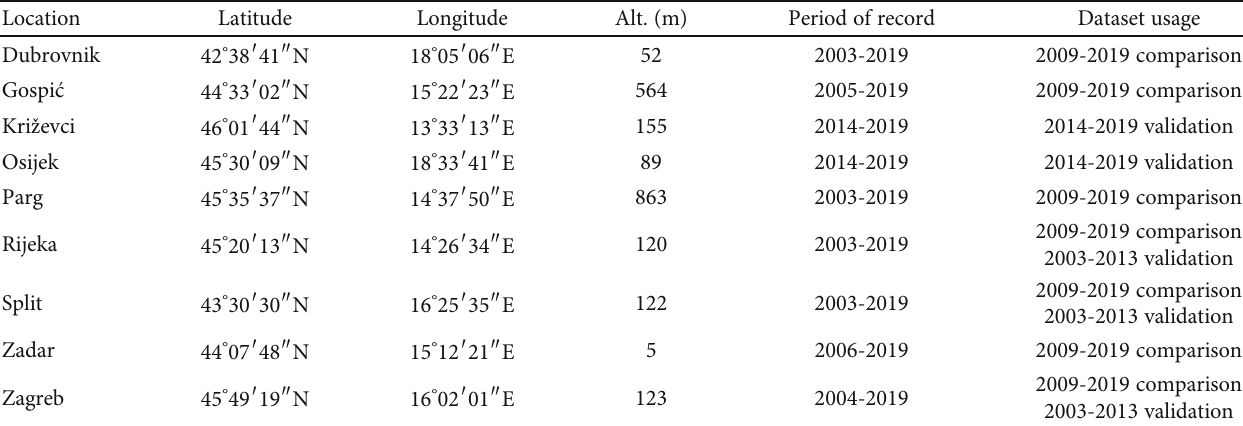
Table 2: List of meteorological stations in Croatia where sunshine duration and global horizontal radiation are measured and datasets used. Location